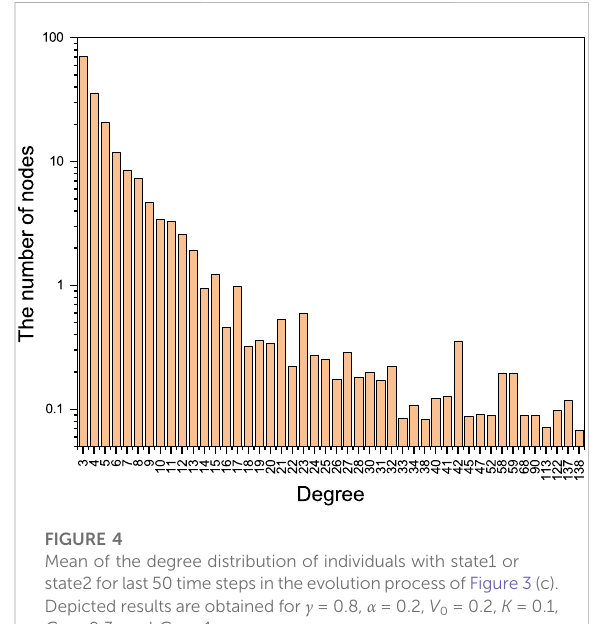
FIGURE 4 Mean of the degree distribution of individuals with state1 or state2 for last50time steps intheevolutionprocess ofFigure 3(c). Depicted results are obtained for γ = 0.8, α = 0.2, V 0 = 0.2, K = 0.1, C V = 0.3, and C H =